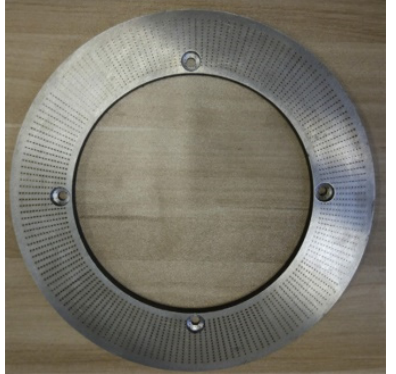
Figure 20. Surface texture of friction disk.